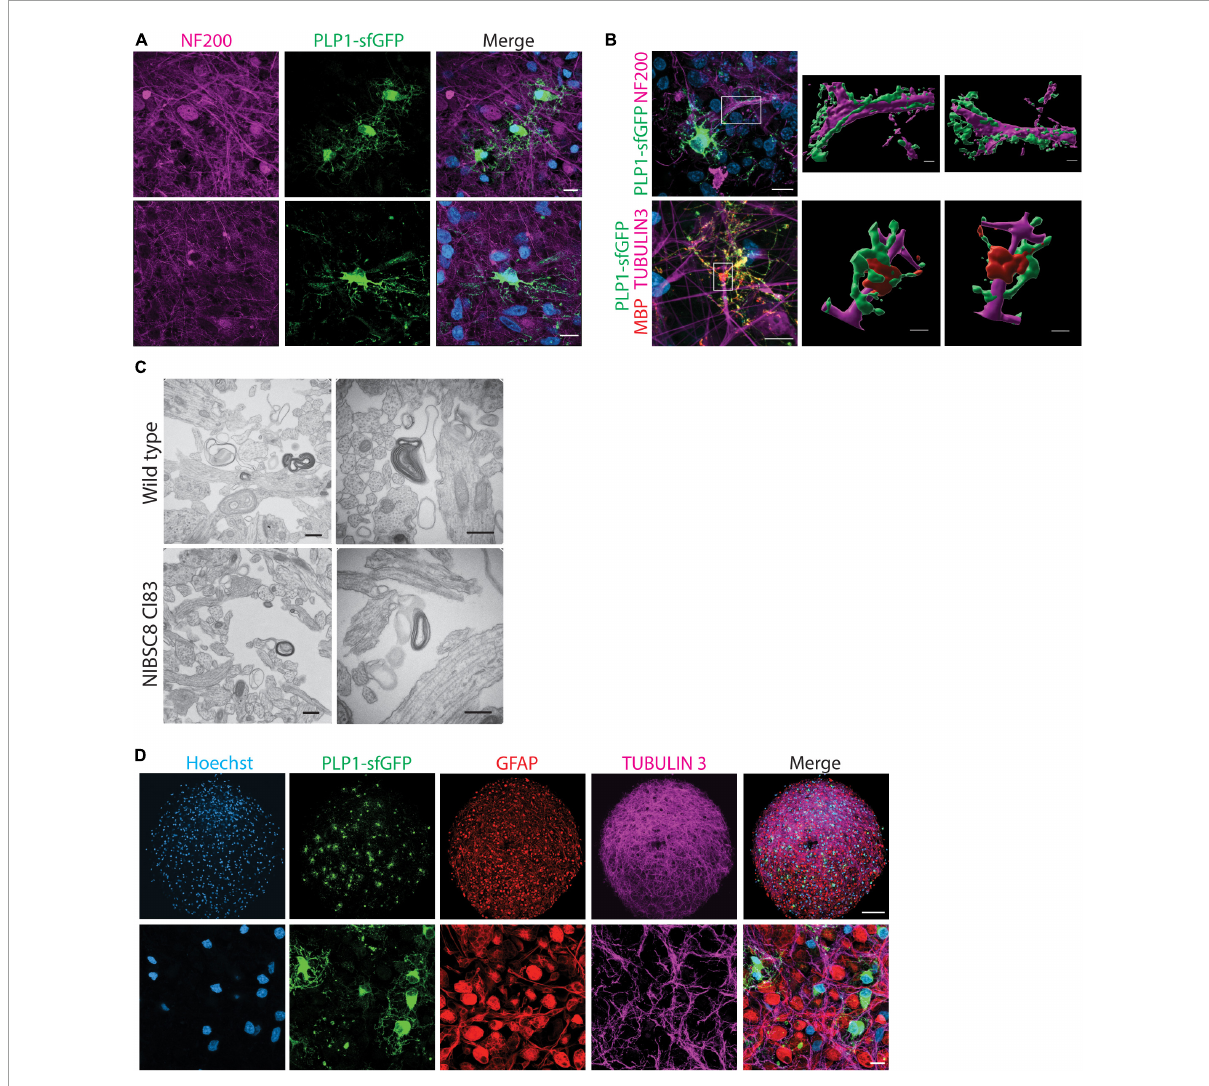
FIGURE5 Functional validation of PLP1-sfGFP fluorescent tag and other cell types present in the bMPS. (A) Representative confocal images of 8-week-bMPS derived from NIBSC8-Cl83 hiPSCs showing sfGFP+ cells (green) with distinct OLs morphology and neuronal axons stained with antibody against neurofilament protein (NF200, magenta). The lower panel displays maximal projection intensity images showing PLP1 located alongside axons. (B) Front- and rear-view of a 3D reconstruction from confocal z-stacks demonstrating PLP1-sfGFP interaction with axons at 8 weeks (upper panel) and MPB and PLP1-sfGFP wrapping around the axons at 10 weeks (lower panel). The color segregation in the image is an artifact of the imaging processing due to single channel 3D rendering; scale bars: 10 µ m, 3D images 2 µ m. (C) Representative TEM images of myelinated axons in wildtype and NIBSC8-Cl83 bMPS (scale bars: 500 nm). (D) Representative confocal images in lower and higher magnifications of 8-week-old NIBSC8-Cl83 bMPS showing neurons (TUBULIN 3, magenta), astrocytes (GFAP, red), and oligodendrocytes (sfGFP, green) markers. The lower panel shows a maximal projection intensity image (scale bar: upper panel 100 µ m; lower panel 10 µ m). A total of 5–8 bMPS were screened per experiment in three independent